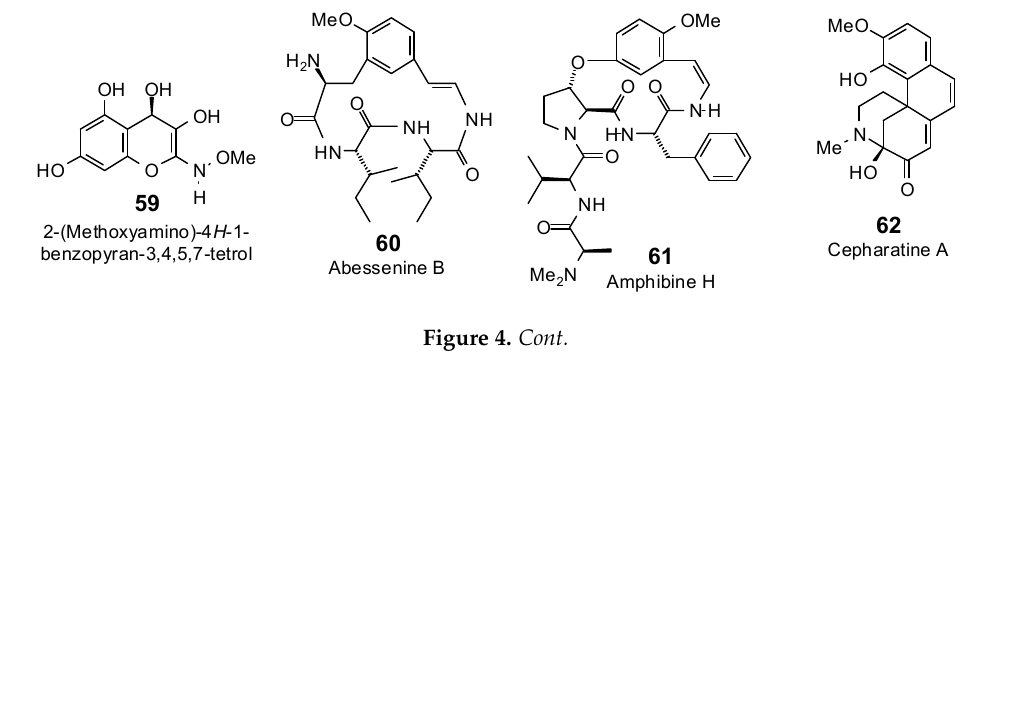
Figure 3. Piperidine, pyrrole, pyrrolizidine, quinoline, and steroidal alkaloids examined in this work.